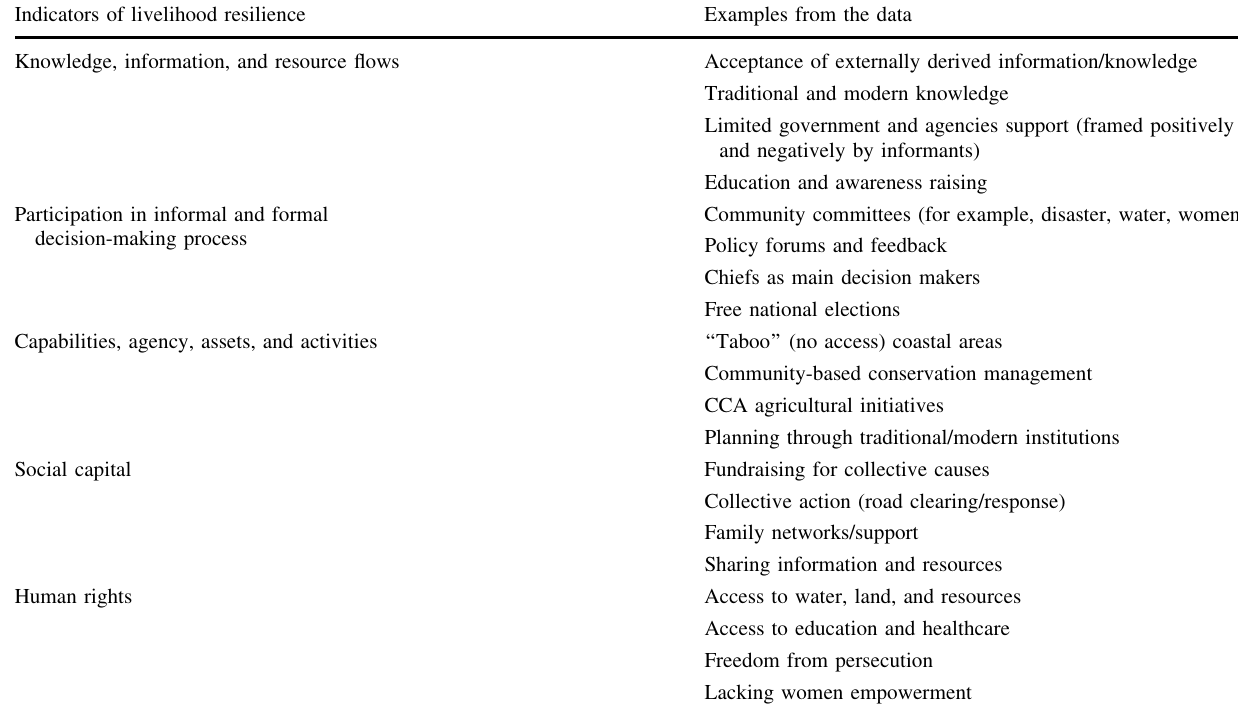
Table 3 Indicators of livelihood resilience in Emae communities Indicators of livelihood resilience Examples from the data Knowledge, information, and resource